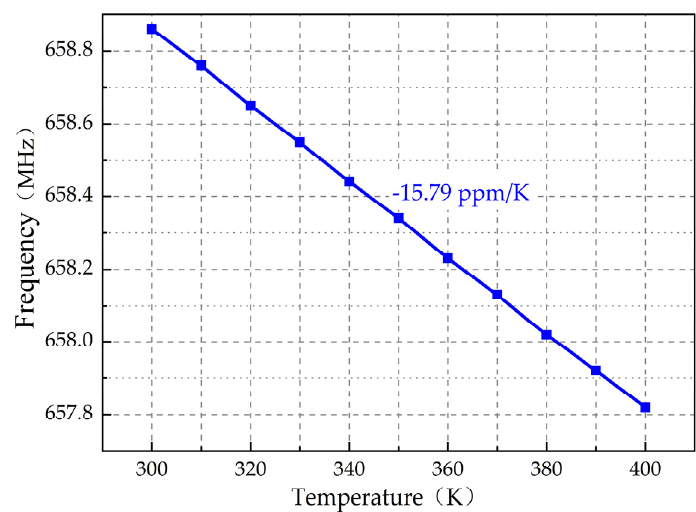
Figure 11. Calculated frequency-temperature profile of the device caused by the temperature coe ffi cient